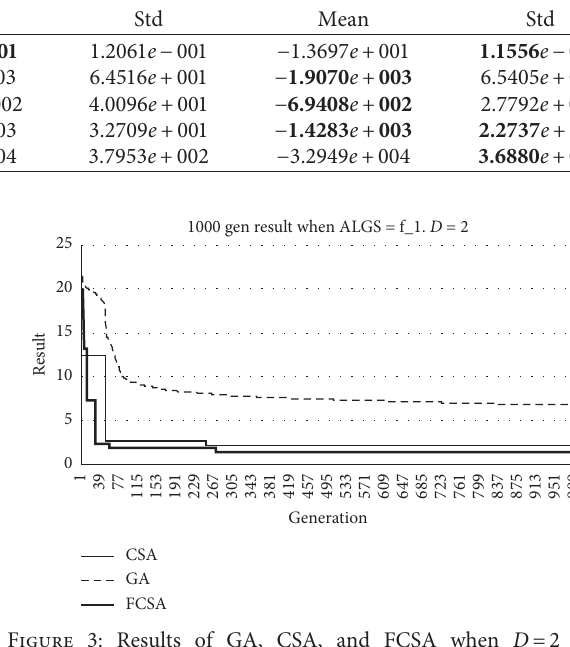
Figure 3: Results of GA, CSA, and FCSA when D � 2 and ALGs �